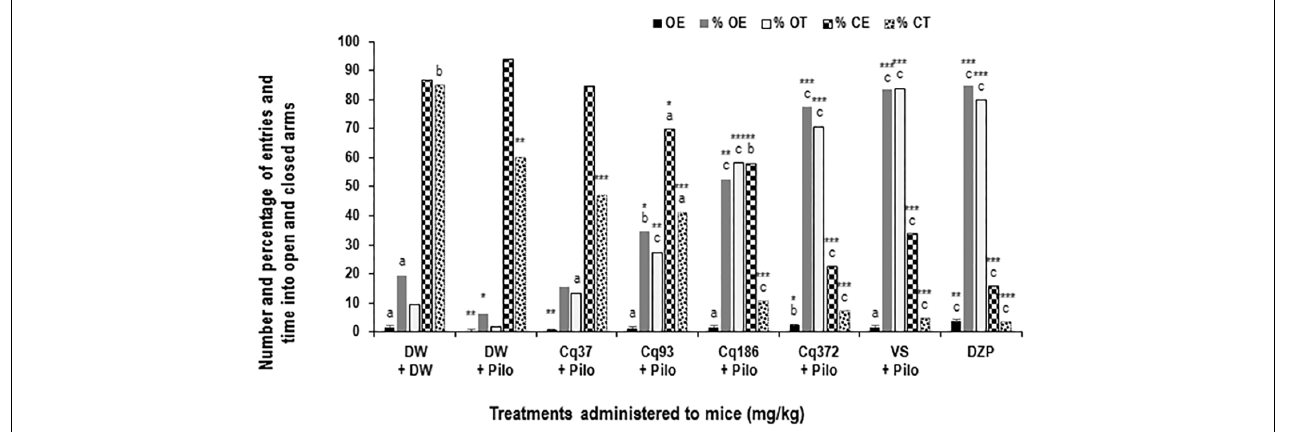
FIGURE 3 | Effects of C. quadrangularis extract on the number of open arm entries, on the percentages of entries and time in opened and closed arms. Results are expressed as mean ± SEM and as percentage for six animals. Data were analyzed by one-way ANOVA, followed by Tukey (HSD). ∗ p < 0.05, ∗∗ p < 0.01, and ∗∗∗ p < 0.001, vs control animals (DW + DW group) receiving only distilled water; a p < 0.05, b p < 0.01, and c p < 0.001 vs disease control animals (DW + Pilo group) receiving distilled water and pilocarpine (360 mg/kg). DW, distilled water; Cq, Cissus quadrangularis ; Pilo, pilocarpine; SV, sodium valproate (300 mg/kg); DZP, diazepam (3